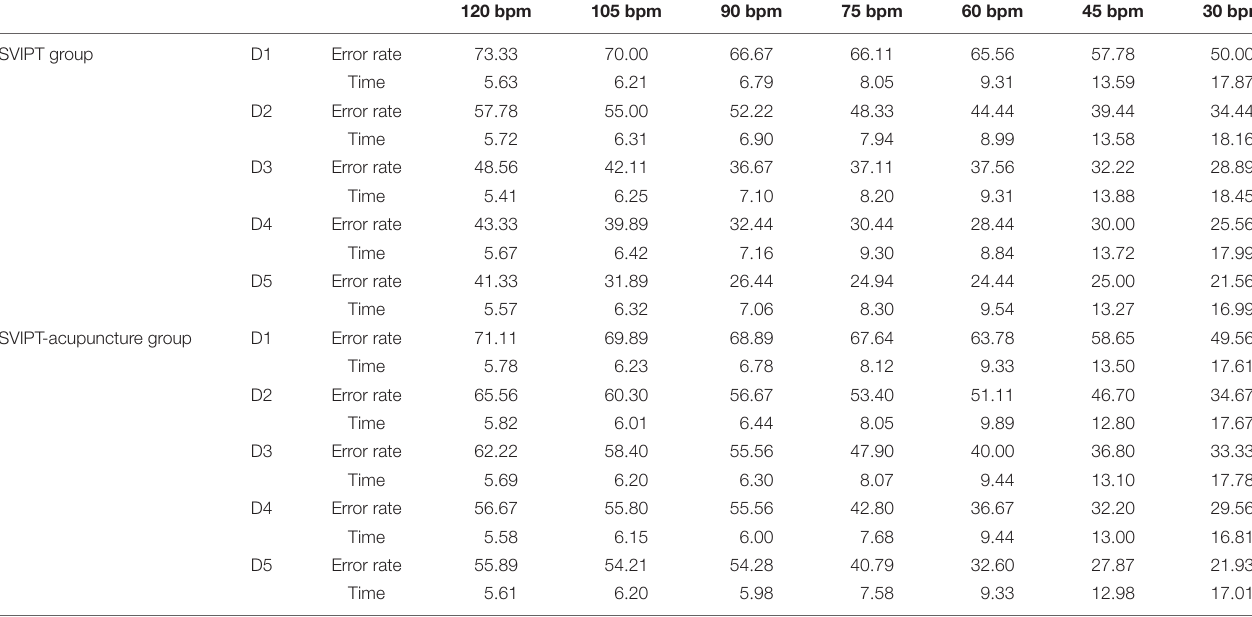
FIGURE 4 | Averaged changes in the MEP amplitude at pre and after iTBS, as well as iTBS with subsequent acupuncture in-off intervention are presented. Data are shown as the mean ± SEM. TABLE 1 | Learning skills index in sequential visual isometric pinch task (SVIPT) and SVIPT-acupuncture